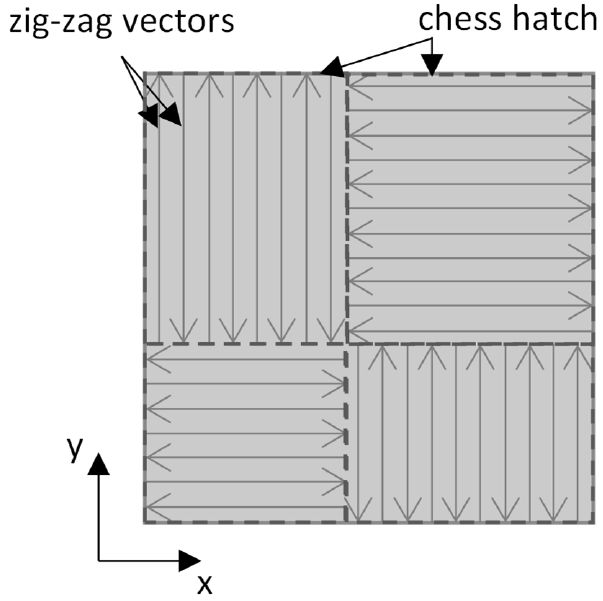
Figure 2. A single layer during the generation of the cube. The beam path vectors inside of the patterns are either perpendicular or parallel to the contour. Table 2. Process parameters used to generate the cubic samples. The values of the absorptance η Abs were taken from